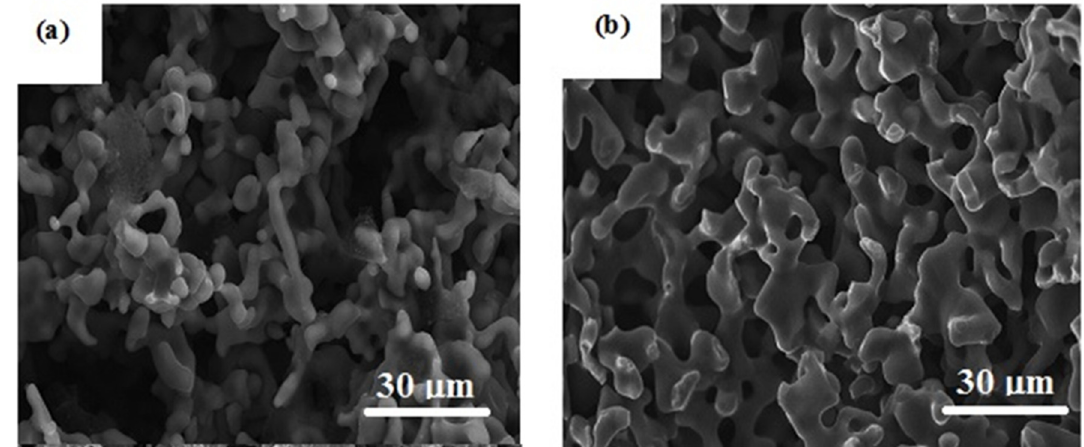
Figure 14. SEM photomicrographs of Fe 2 O 3 / charcoal composites reduced at different heating rates: ( a ) 20 °C/min and ( b ) 5 °C/min.